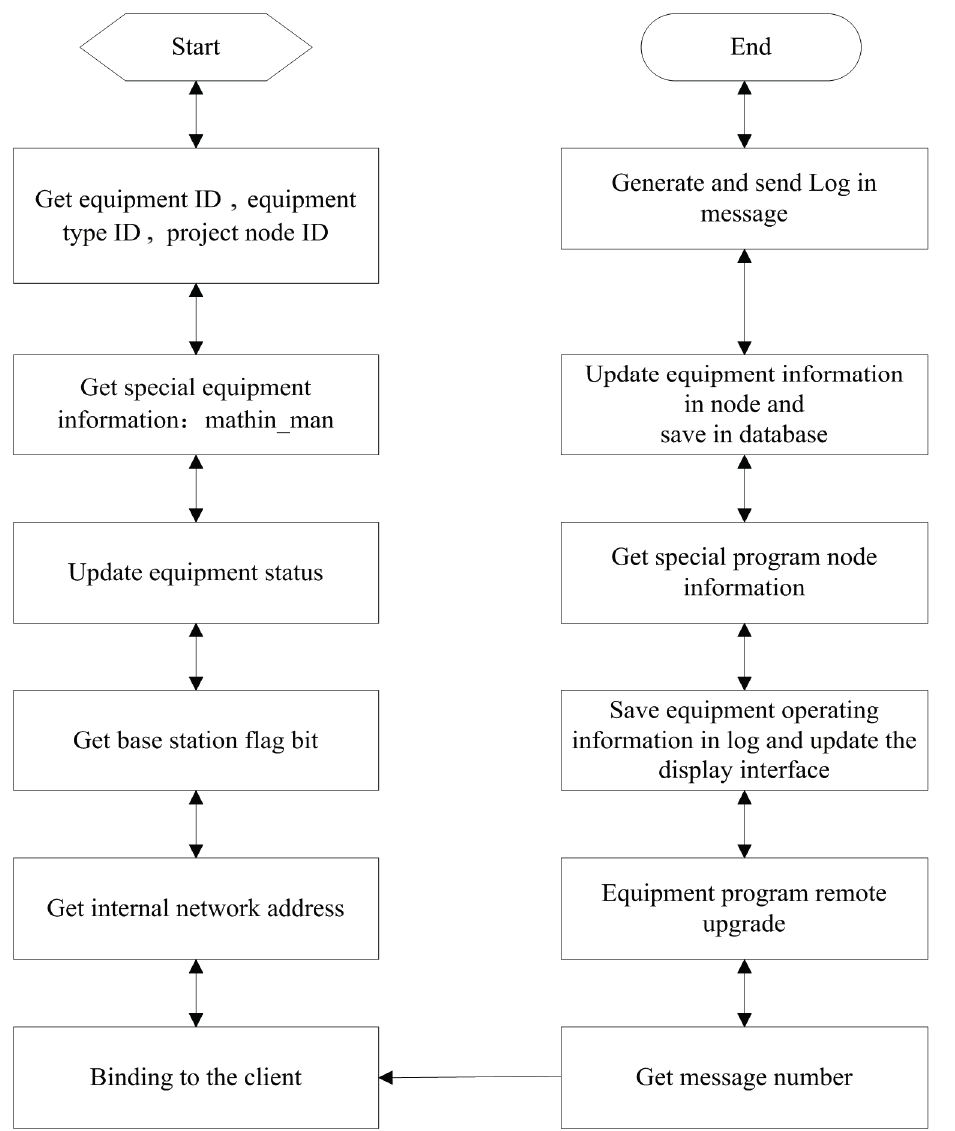
Figure 7. Data transmission during the login